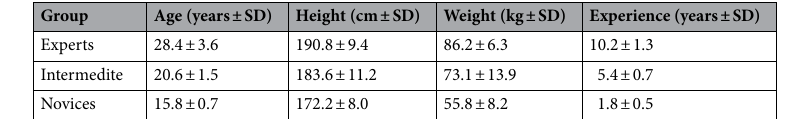
Table 4. Characteristics of examined group (mean ± standard